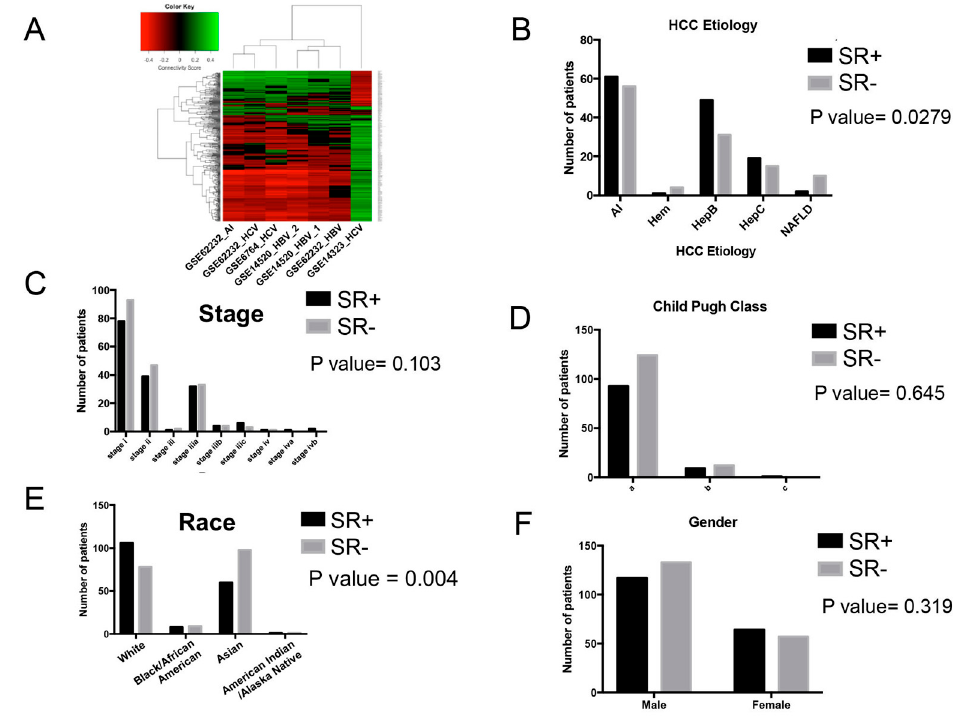
Figure 6. Impact of clinical and demographic factors on drug repurposing candidates and sorafenib resistance gene signature. ( A ) Heatmap visualization of hierarchical clustering analysis of connectivity scores for LINCS drugs derived from gene expression profiles of HCC patient tumor datasets from the GEO database representing distinct etiologies. ( B ) Proportions of SR+ and SR- patient primary HCC tumors in the TCGA LIHC dataset across five HCC etiologies (chi-square test). Proportions of HCC patients with primary SR+ and SR- tumors in the TCGA LIHC dataset across ( C ) stage based on TNM classification (chi-square test p value reported), ( D ) Child–Pugh class (chi-square test p value reported), ( E ) patient race (chi-square test p value reported) and ( F ) patient gender (Fisher exact test p value reported). Note the mean age at diagnosis for SR+ and SR − patients is 59.5 years and 59.4 years, respectively. Abbreviations: AI = alcohol-induced, HBV = hepatitis B virus, HCV = hepatitis C virus, NAFLD = non-alcoholic fatty liver disease, Hem = hemochromatosis.